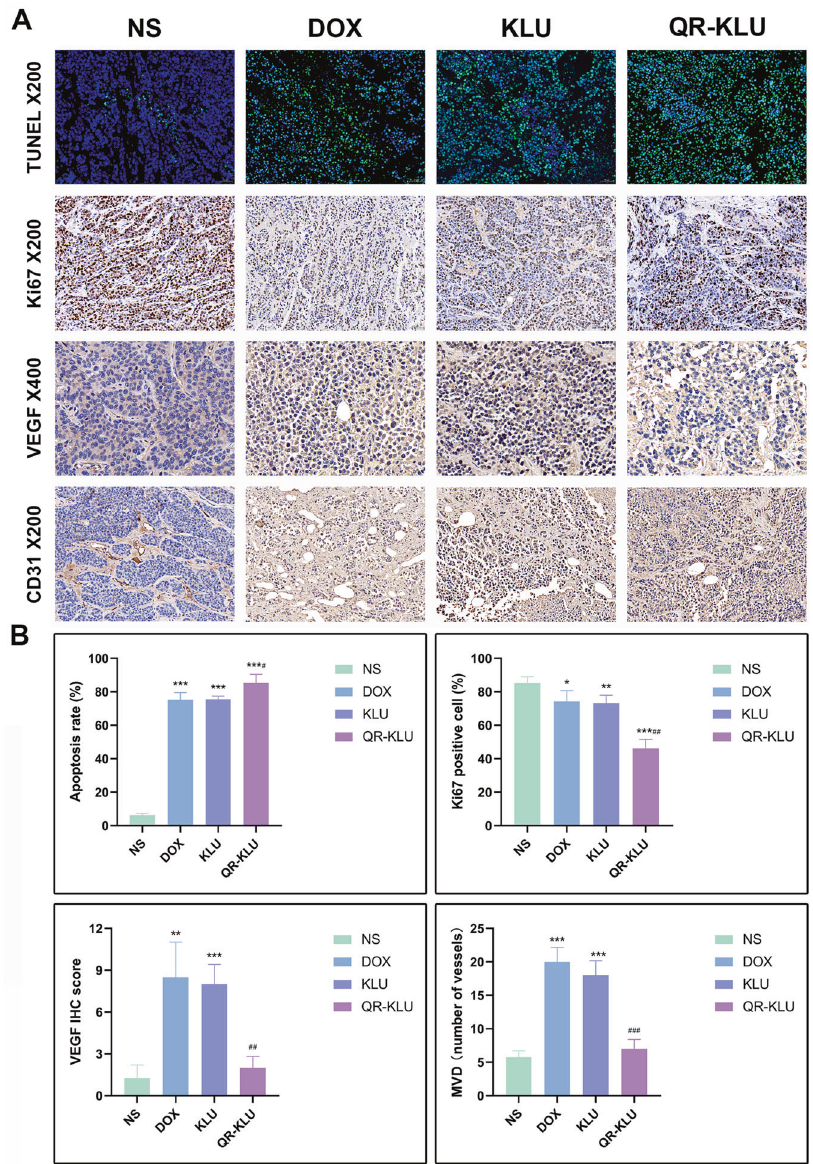
Fig. 6 Peptide QR-KLU promotes tumor cell apoptosis, inhibits tumor cell proliferation and the expression of VEGF and CD31. A Representative images of TUNEL assay, Ki67, VEGF and CD31 expression detected by immunohistochemistry (IHC) staining in the four groups. B Comparisons of the tumor apoptosis rate, Ki67 positive cell, VEGF IHC score and microvessel density (MVD) in the four groups. *** P < 0.001 versus NS group, ** P < 0.01 versus NS group, ### P < 0.001 versus DOX group, ## P < 0.01 versus DOX group, # P < 0.05 versus DOX